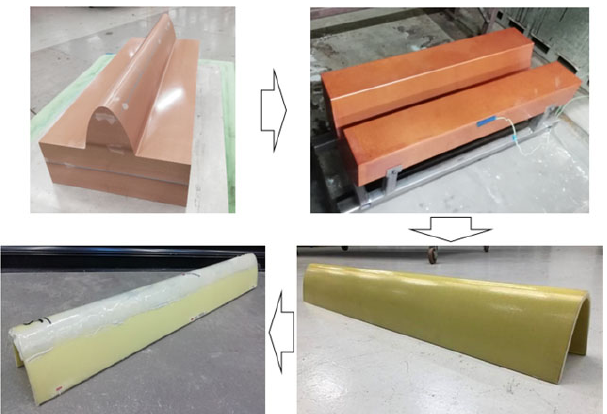
Figure 4. Summary of the main manufacturing stages for the demonstrator, from top left clockwise: demonstrator pattern, ther- moset mould, powder epoxy glass-fibre reinforced leading edge demonstrator and demonstrator with LEP bonded in place.